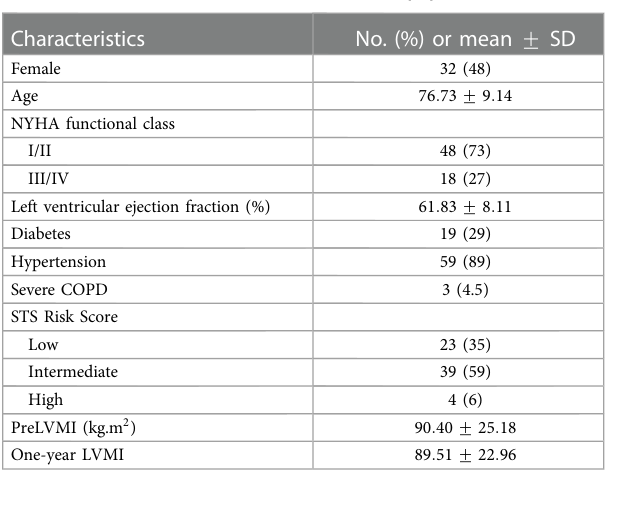
TABLE 1 Patients ’ Characteristics for the studied population.